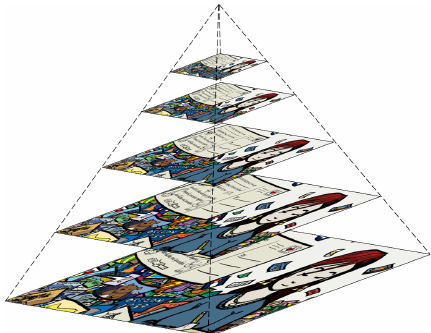
Figure 4. Diagram of the Gaussian pyramid